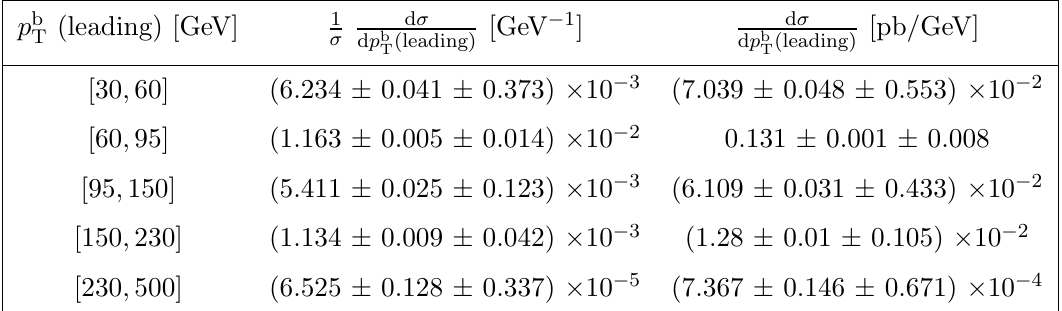
Table 41 . The measured di(cid:11)erential cross section and bin boundaries for each bin of the normalized and absolute measurements of the tt di(cid:11)erential cross section at particle level in the (cid:12)ducial phase space as a function of p b (leading) are tabulated. T